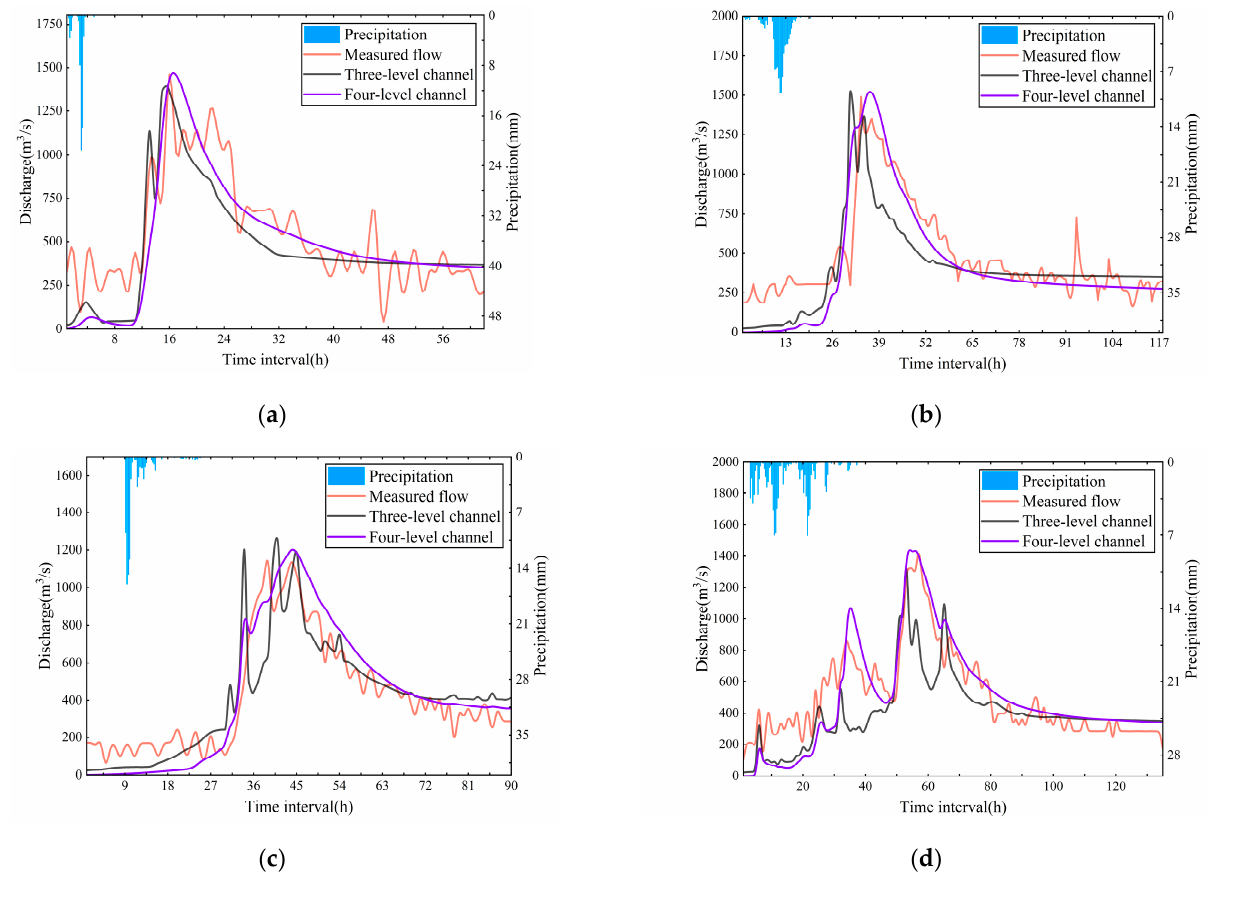
Figure 6. Simulation processes of representative floods with flood number: ( a ) 2010052211; ( b ) 2016052003; ( c ) 2019041710; and ( d ) 2020060703. ( b ) 2016052003; ( c ) 2019041710; and ( d )